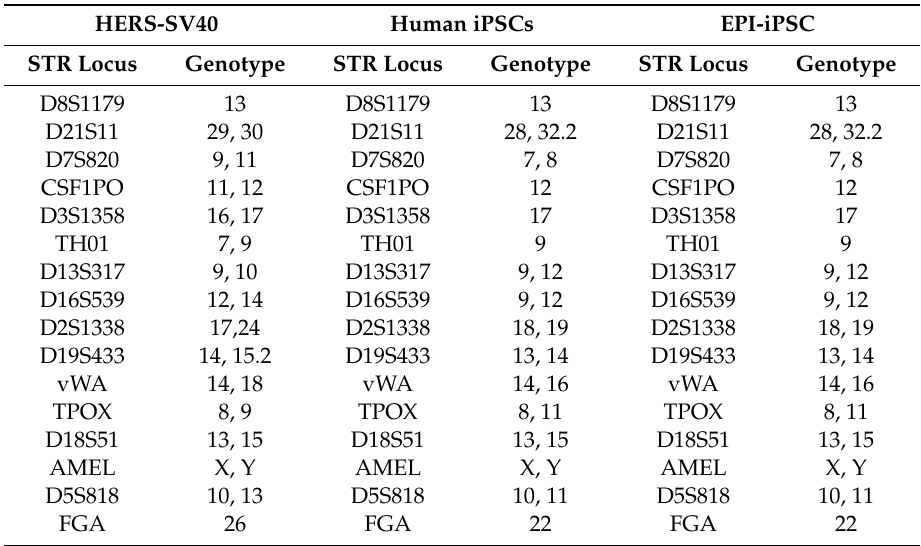
Table 1. STR analysis showed that the EPI-iPSC cell line matched human